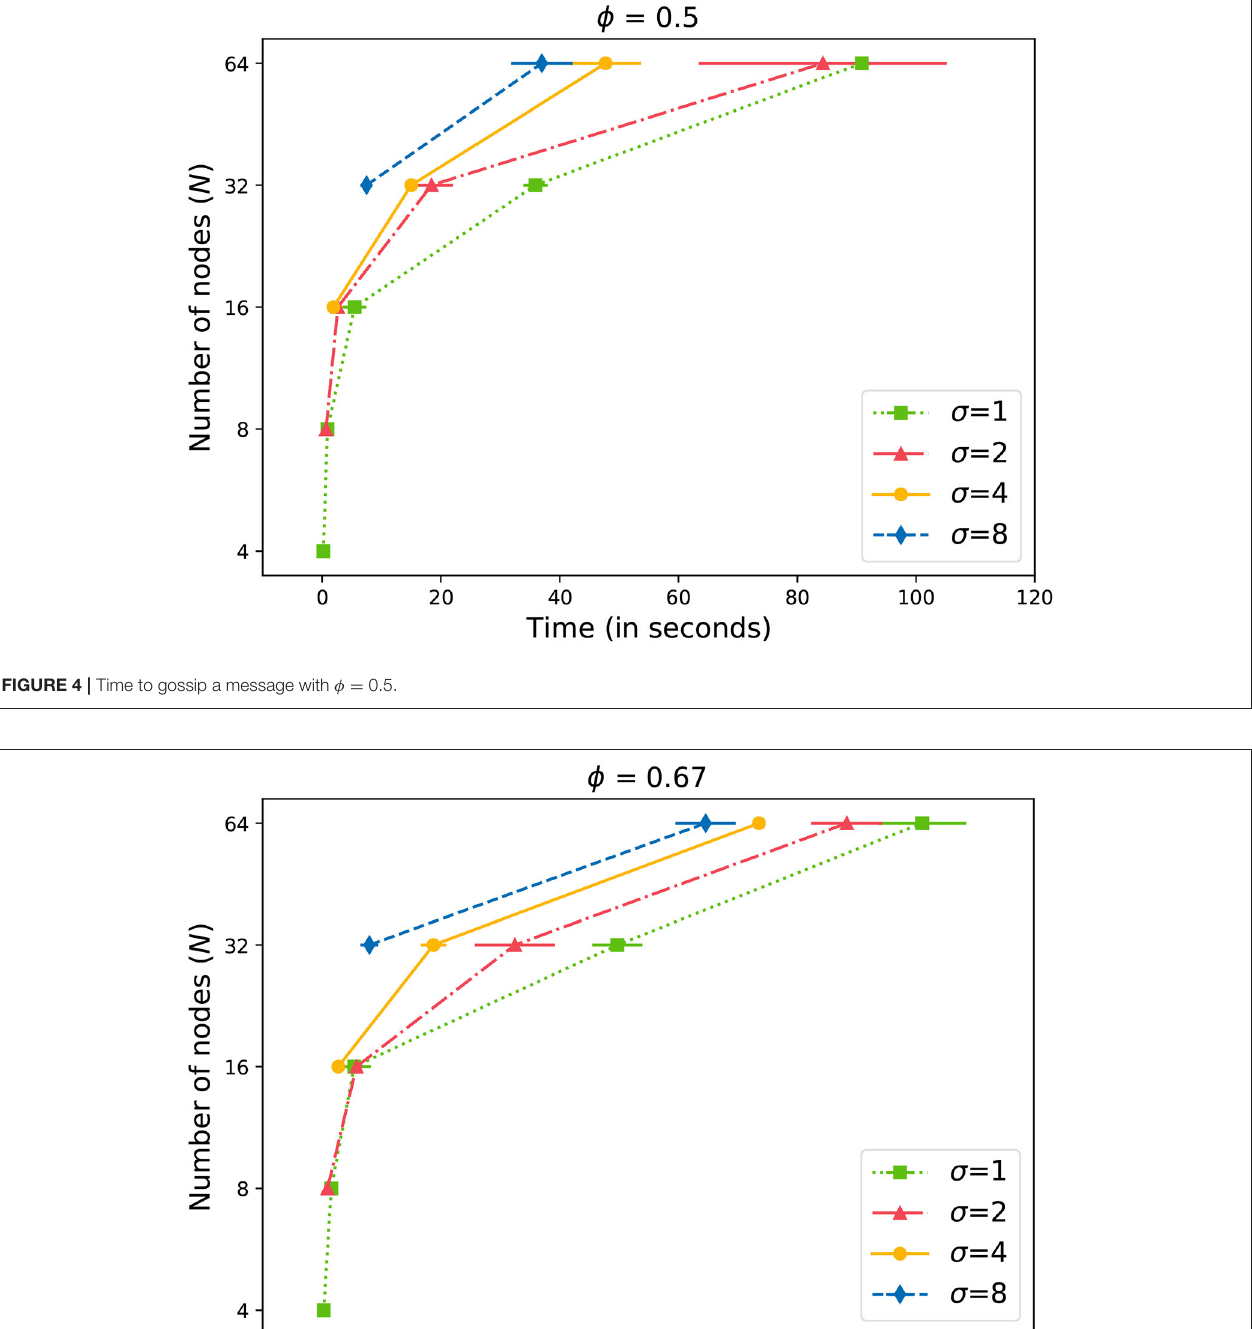
In our experiments, we doubled the value of σ in each step. The results illustrate that the updates can be propagated within an expected time